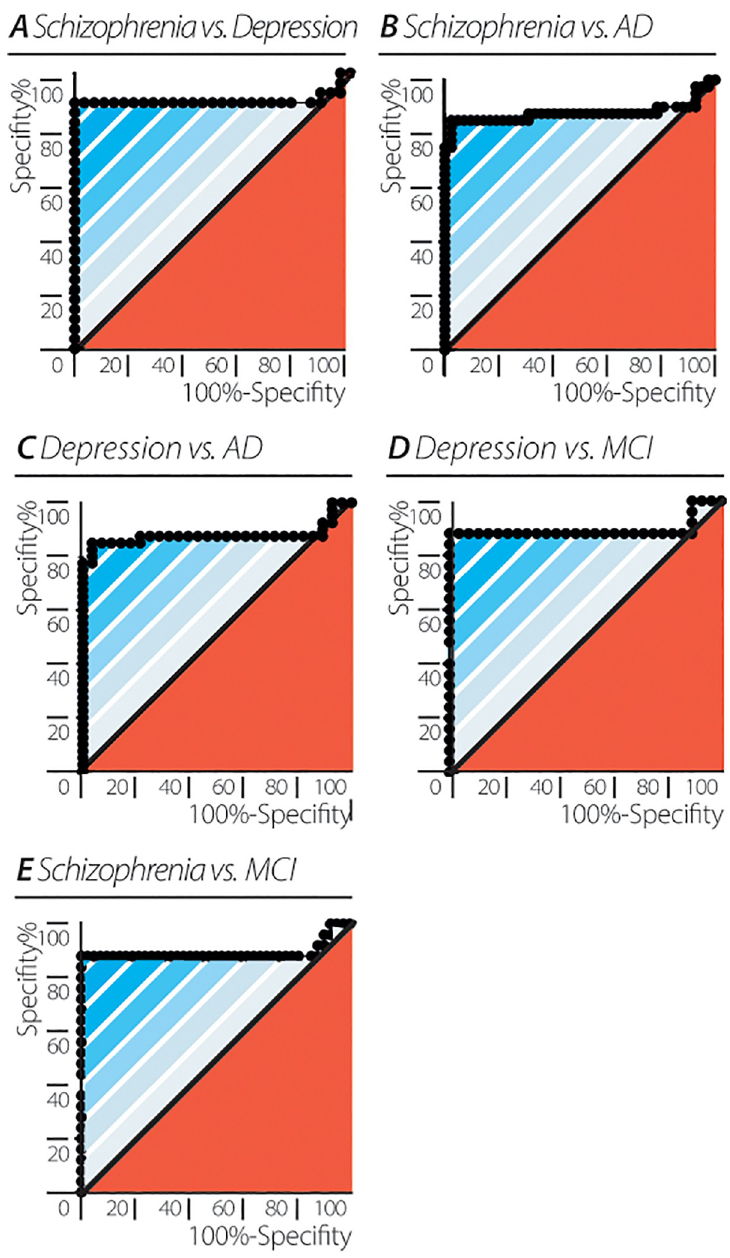
Fig 5. Differentiating between neuro-psychiatric patient groups by EEG quantum potential mean and variability score (qpmvs). Accuracy depicted as receiver operating characteristic (ROC) curves for (A) schizophrenia vs. depression (AUC = 0.8992 ± 0.055, 95% CI: (0.7910–1.000), p = < 0.0001). (B) schizophrenia vs. AD (AUC = 0.8762 ± 0.048, 95% CI: (0.7818–0.9706), p = < 0.0001). (C) schizophrenia vs. MCI (AUC = 0.8914 ± 0.059, 95% CI: (0.7756– 1.000), p = < 0.0001). (D) depression vs. AD (AUC = 0.8777 ± 0.048, 95% CI: (0.7828–0.9726), p = < 0.0001). (E) depression vs. MCI (AUC = 0.8929 ± 0.058, 95% CI: (0.7781–1.000), p = < 0.0001).